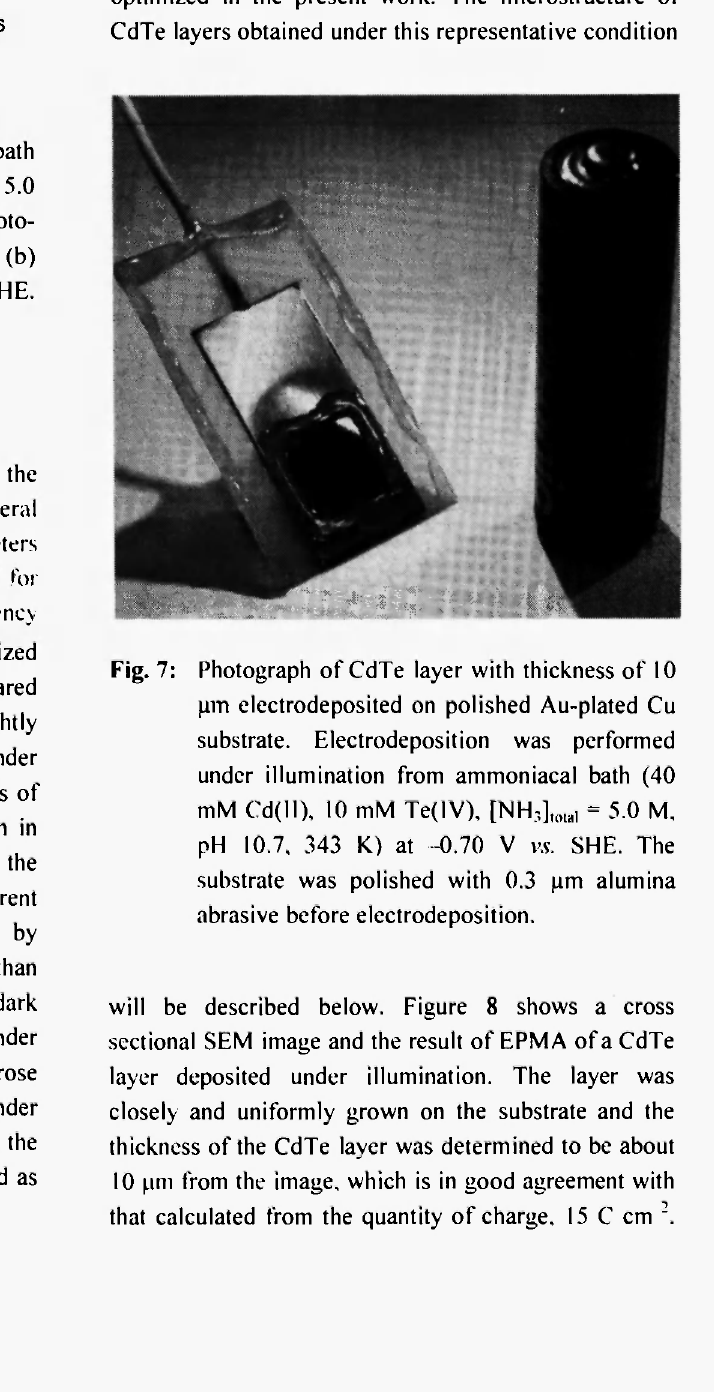
Figure 7 is a photograph of a CdTe layer of '55 » thickness 10 μηι electrodeposited on a polished Au- 04 1 plated Cu substrate, showing a flat and mirror-like ö surface of the CdTe. The electrolysis was performed at 08 -0.70 V with 15 C cm 2 under illumination from a basic